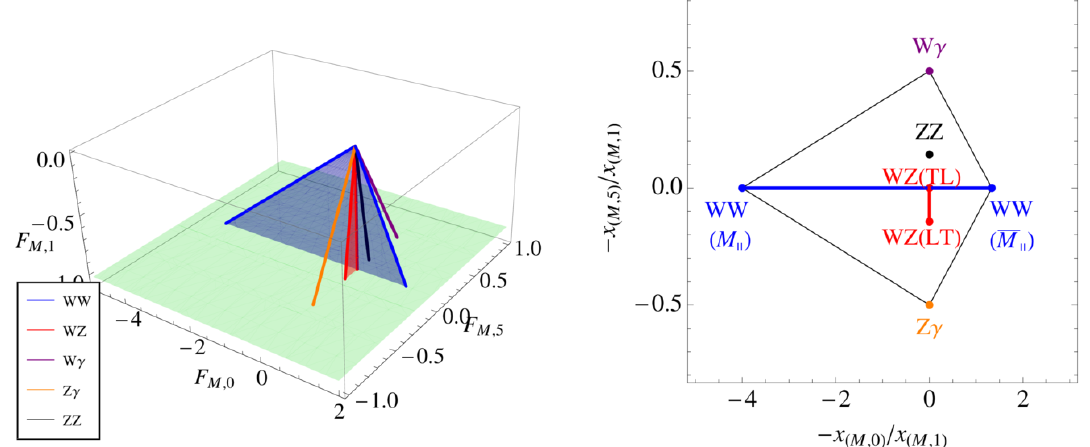
Figure 6 . Left: the vectors ~x i ( ~a;~b ) intersect the plane x points. Right: the intersection points ~P i ( ~a;~b ) = ( (cid:0) x plane. The colors represent di(cid:11)erent scattering channels. The M denote the corresponding polarisation con(cid:12)guration that gives the endpoints of the line segments, see table 1 in section